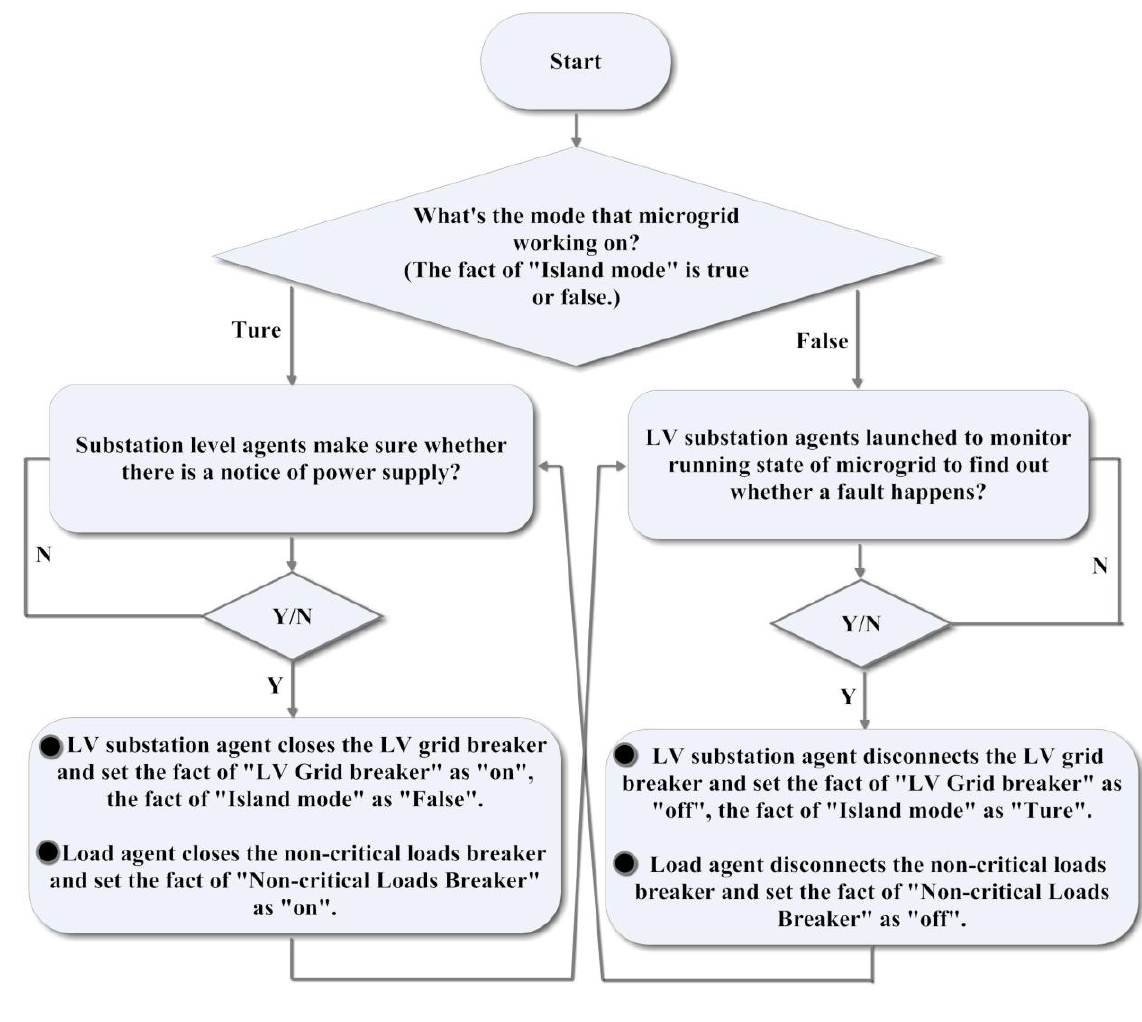
Figure 7. The flow chart of MAS